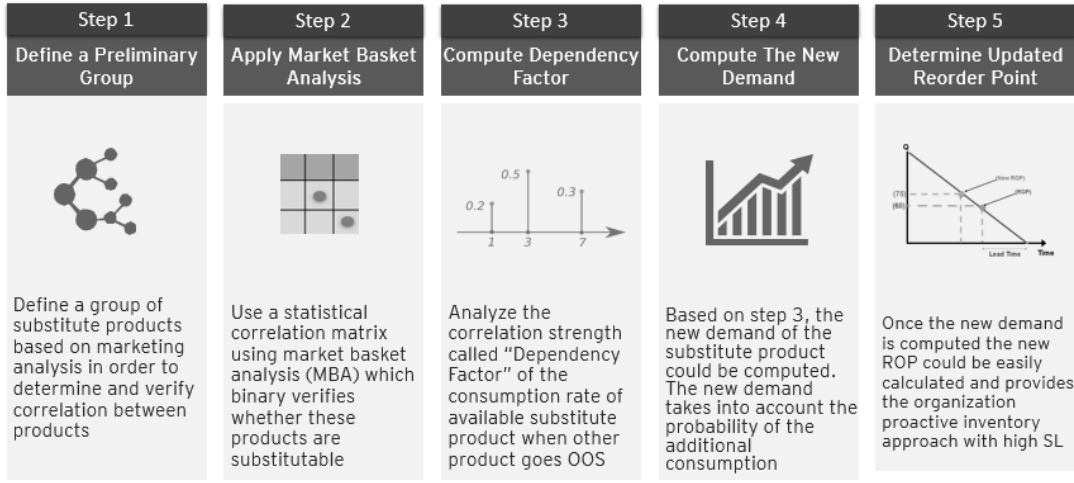
Figure 2 : The Five Steps of the